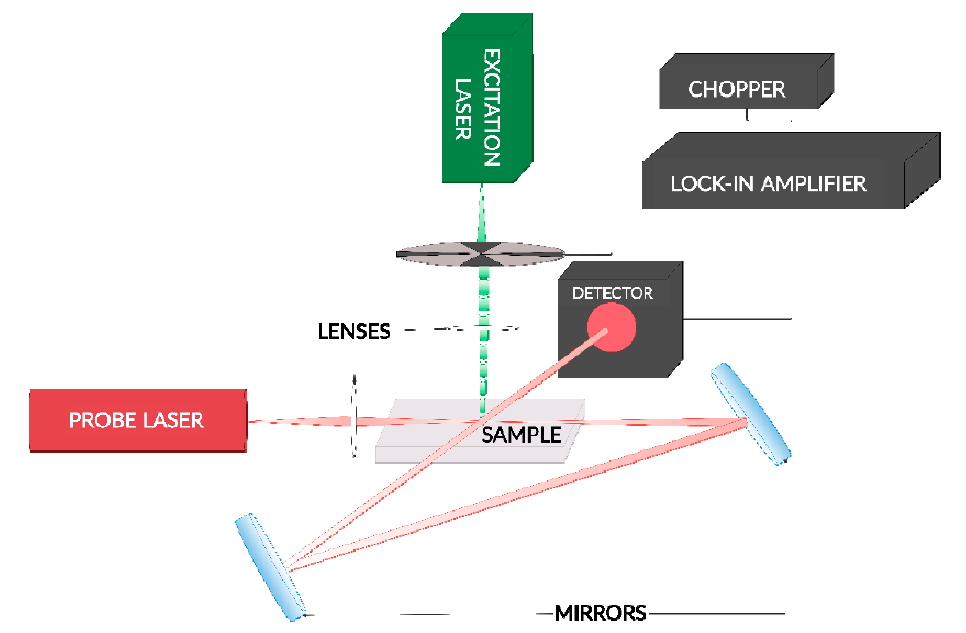
Figure 2. Scheme of the experimental setup used to perform the BDS measurements.